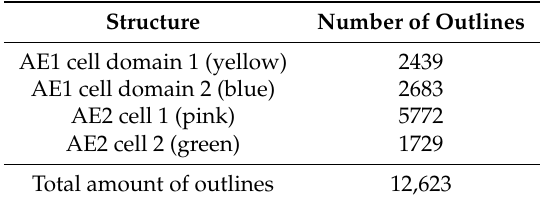
Figure 1. Overview of the 3D model. The figure shows an overview of the 3D model from an alveolar viewing direction. The model includes an almost complete type 2 alveolar epithelial (AE2) cell (pink) and parts of another AE2 cell (green) as well as two type 1 alveolar epithelial (AE1) cell domains (blue and yellow), which are labeled as AE2 and AE1, respectively. The filled arrowhead indicates a deep recess between the pink and green AE2 cells as well as the yellow AE1 cell. The AE2 cells show abundant microvilli on their surfaces but also plain parts (empty arrowhead on the pink AE2 cell, for example). The luminal AE1 cell surface may also be plain at a certain spot (asterisk) or enlarged somewhere else (hash key). Scale bar: 1 µ m. Table 1. Number of outlines manually segmented for